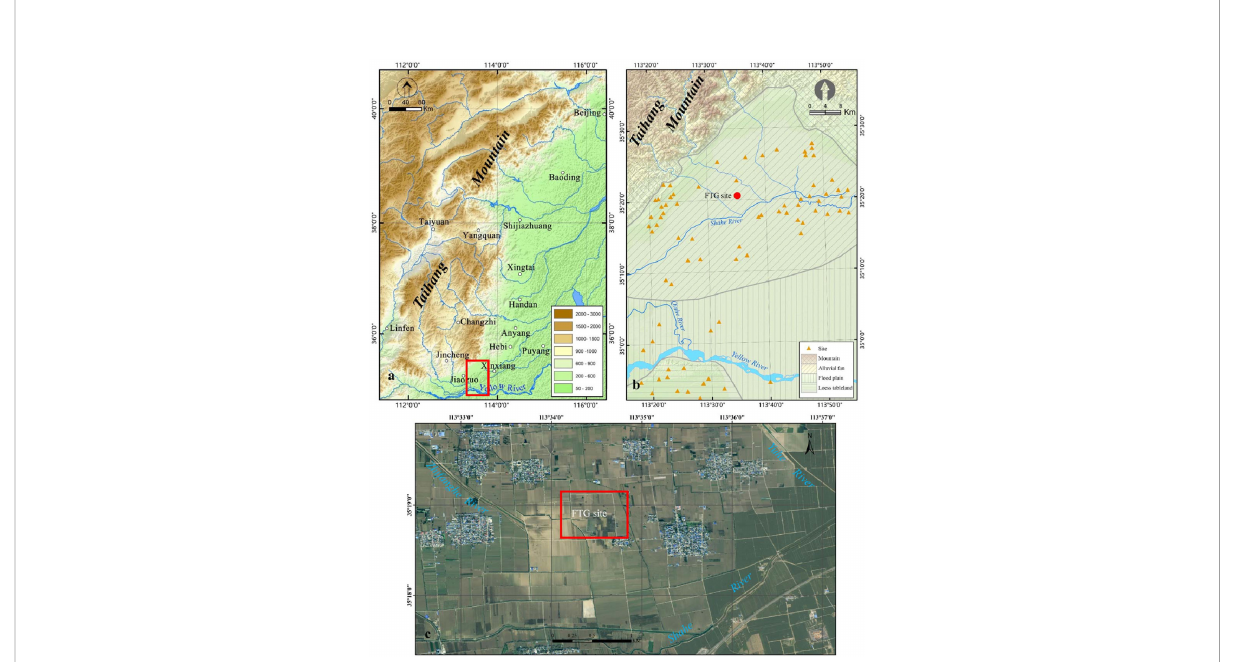
FIGURE 1 The study area (A) . There are a lot of ancient and modern cities in the piedmont of Taihang Mountain, which is our study area and has been marked with a red rectangle; (B) The geomorphic types and Neolithic-Bronze sites in the study area. The red circle represents the location of the FTG site; (C) The terrain and river system in the FTG site area. The image comes from Map